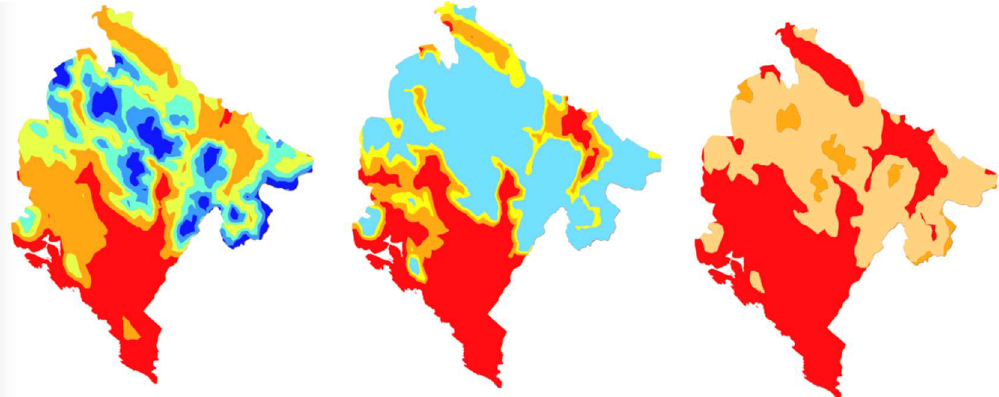
Figure 4. The climate zones over Montenegro according to the Köppen classification for (left) 1981–2010 (center) 2001–2030 climatology (right) 2071–2100. The Köppen zones are represented by the following color code: Csa—red, Csb—dark orange, Csax”—light orange, Csbx”—yellow, Cfb—light blue, Cfbx”—medium blue, Dfbx”—dark blue.